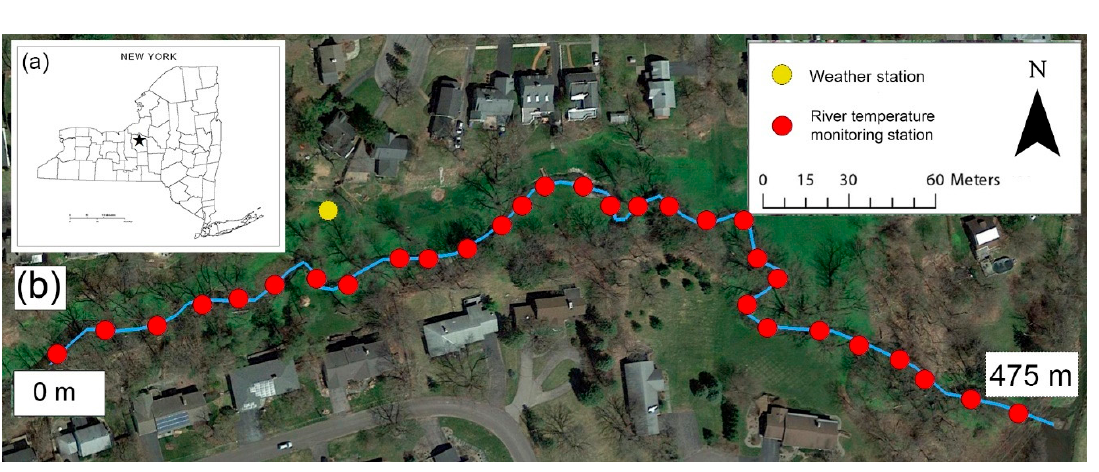
Figure 3. ( a ) New York State with the Meadowbrook Creek study area denoted by the star. ( b ) Figure3. ( a )NewYorkStatewiththeMeadowbrookCreekstudyareadenotedbythestar. ( b )Monitoring Monitoring stations and reach distances along Meadowbrook Creek. stations and reach distances along Meadowbrook